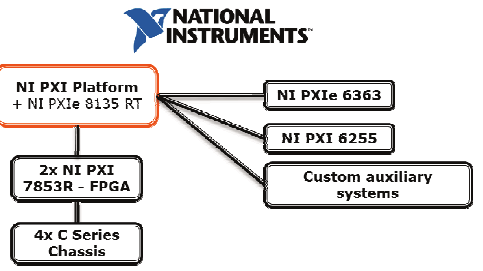
Fig. 8. Block diagram of data acquisition system